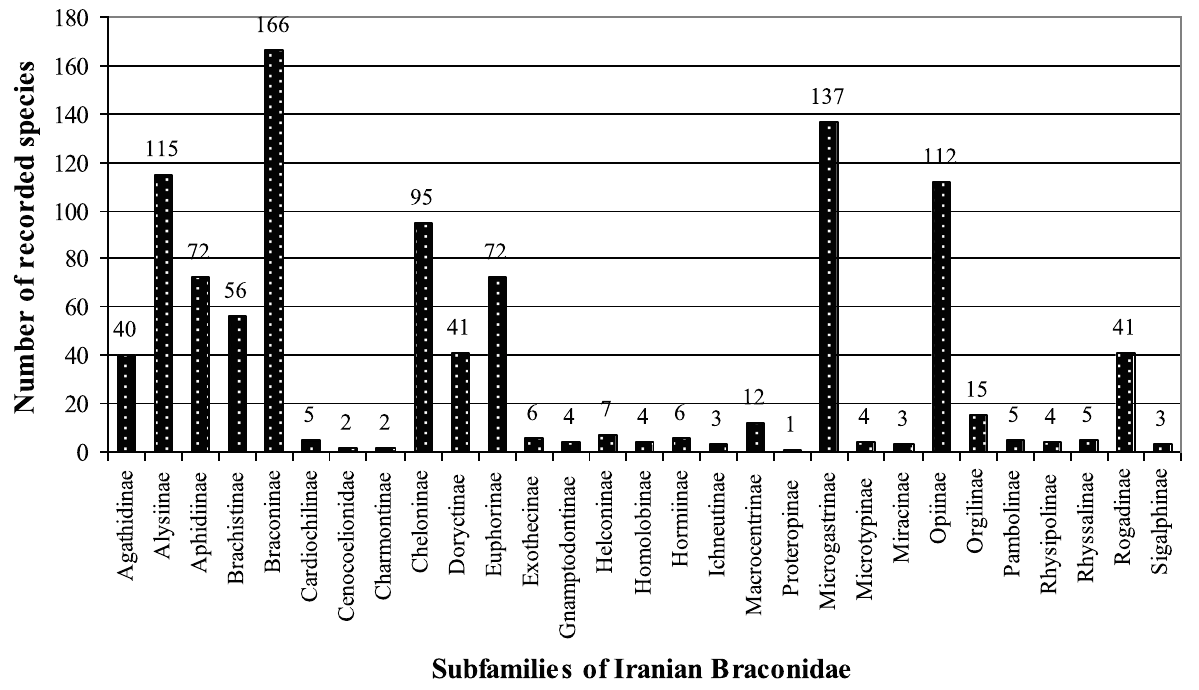
Fig. 2 Species diversity of Iranian Braconidae by subfamilies (adapted from Samin et al. 2018b, in addition to other eight studies with new records after that: Gadallah et al. 2018, 2019, Ghahari and Gadallah 2019, and Ghahari et al. 2019; Samin et al. 2019a, b, 2020)